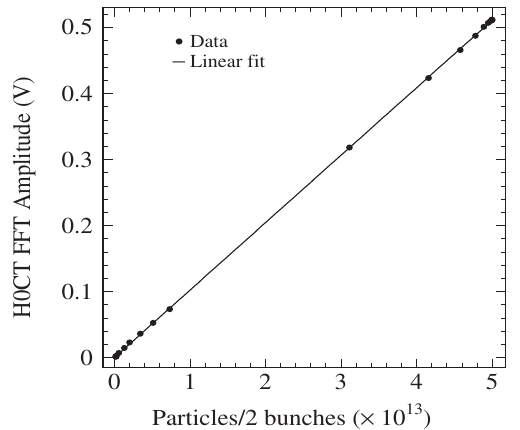
FIG. 9. FFT amplitude of the H0CT data as a function of the beam intensity. The solid circles are the measurement data for each corresponding beam intensity where the solid line is a linear fit. The linearity was found to be very good throughout the whole intensity range used in the present